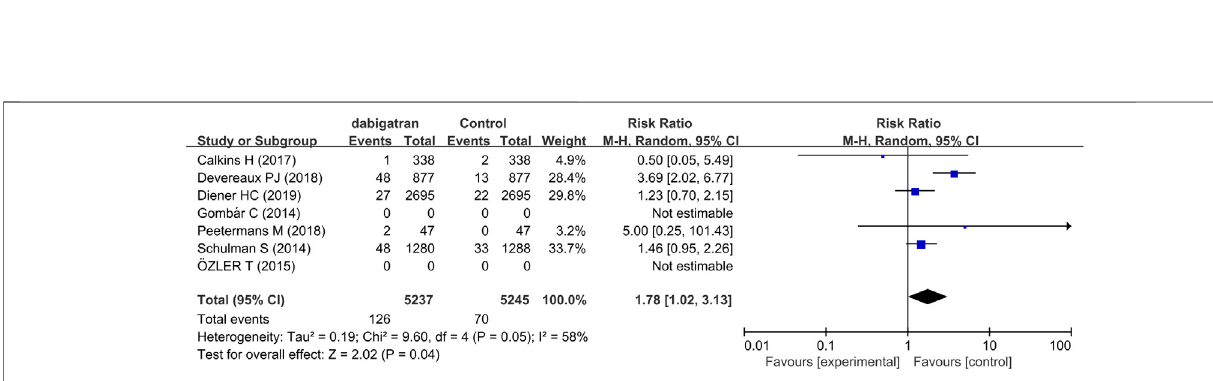
FIGURE 6 | Forest plot comparing the RR of GI bleeding between the experimental (dabigatran) and control groups.